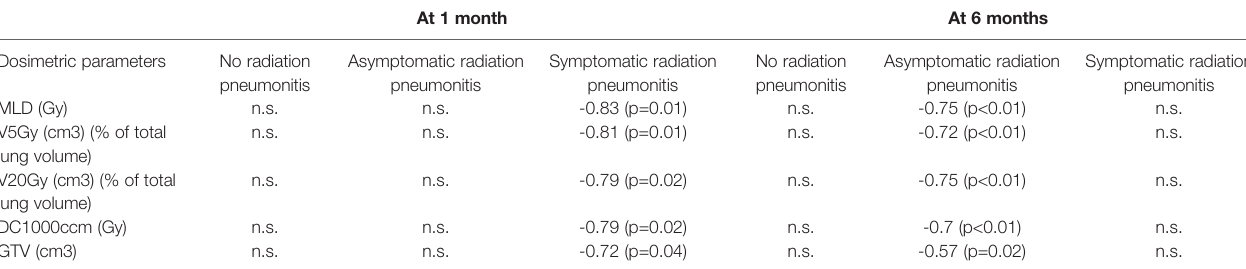
TABLE 3 | Signi fi cant negative correlations between dosimetric parameters and FEV1-drop (%) according to Spearman correlation. At 1 month At 6 months Dosimetric